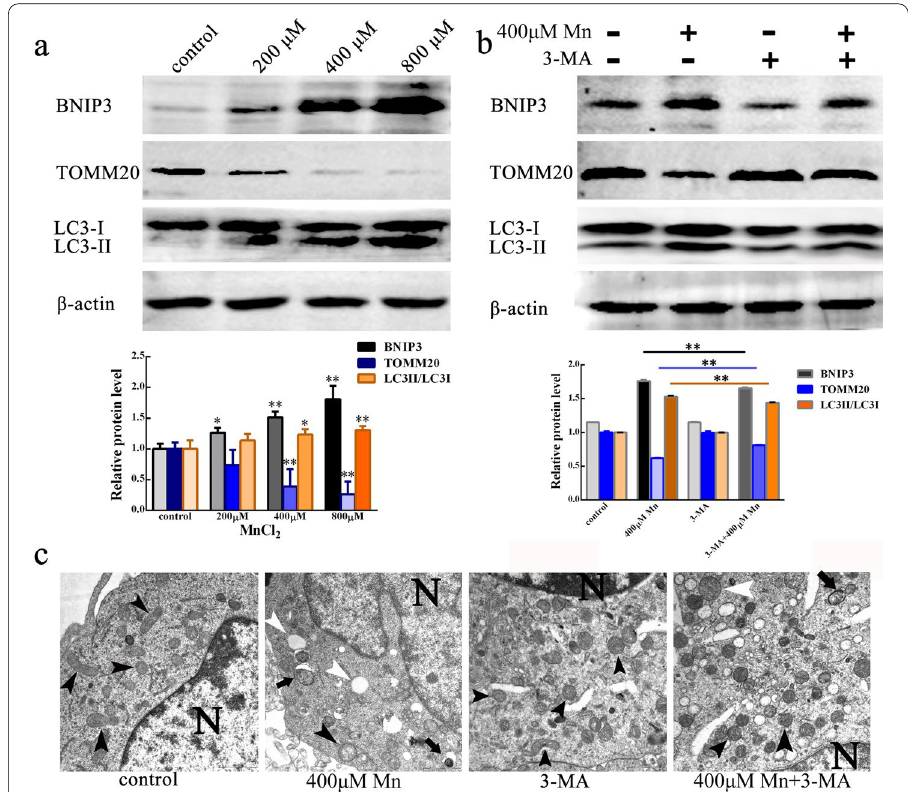
Fig. 2 MnCl 2 induced mitophagy in SH-SY5Y cells. a , b BNIP3, LC3 and TOMM20 protein levels were measured by western blot after SH-SY5Y cells were treated with 200, 400, 800 µM MnCl 2 ( a ) and treated with 400 µM MnCl 2 alone or co-treated with mitophagy inhibitor 3-MA together ( b ) for 24 h. β-actin served as an internal reference. Compared with control, * P < 0.05, ** P < 0.01. c Mitophagy bodies and mitochondria treated with 400 μM MnCl2 alone or co-treated with mitophagy inhibitor 3-MA together for 24 h were observed by transmission electron microscopy (TEM). N, nucleus. White arrow, expanded, condensed or dissolved, mitochondria aggregate. Black arrowhead ( ), relatively normal mitochondrial morphology. Black